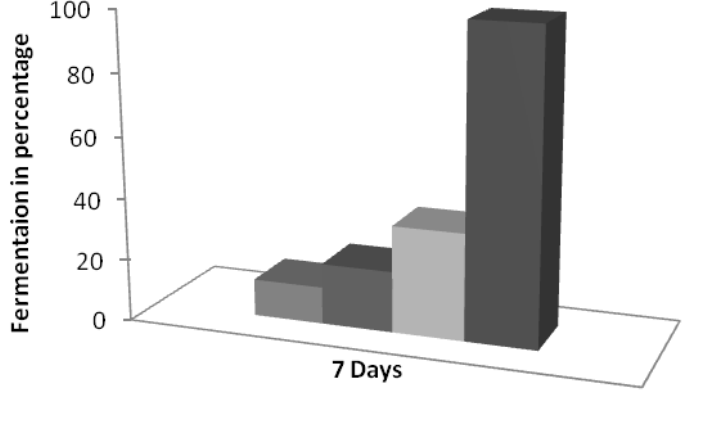
Figure 2 . Sugar fermentation capacities of one isolated strain (Mi4) after seven days, measured as ethanol production and expressed as % of the control strain*: Saccharomyces cerevisiae growing on glucose,